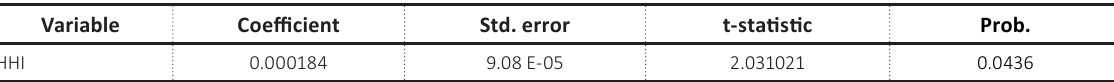
Source: Data processed by the